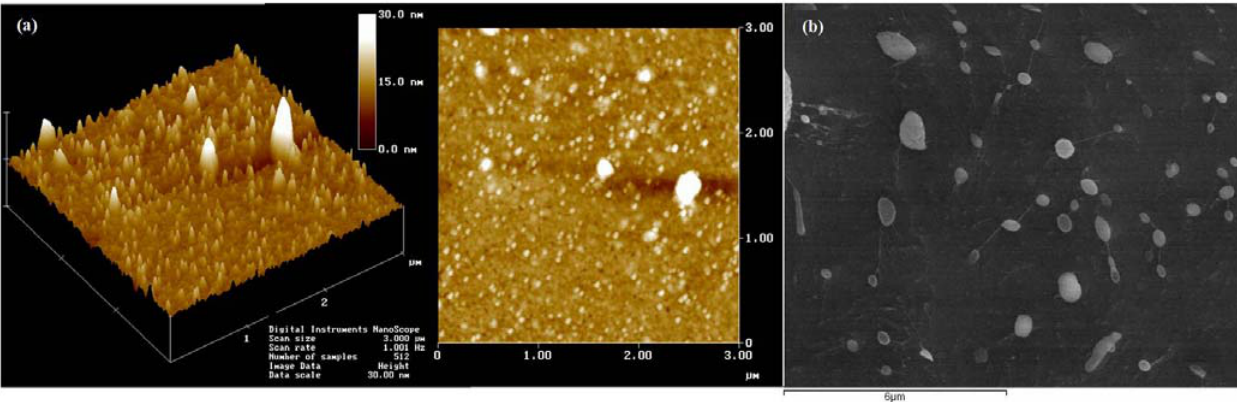
Figure 1. Size of dextrin nanoparticles evaluated by (a) atomic force microscopy and (b) cryo-scanning electron microscopy, adapted from